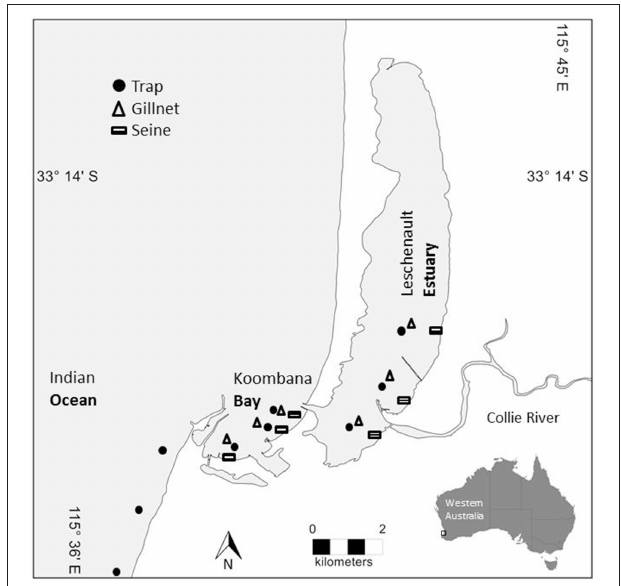
FIGURE 1 | Map of prey sampling sites within the Bunbury study area. Trap sites are denoted with a circle, gillnet sites are denoted with a triangle, and seine net sites are denoted with a rectangle. Sites span the lower reaches of the Leschenault Estuary, the breadth of Koombana Bay (between the Estuary and the coastal water), and the coastal waters (Ocean) outside of the Bay (traps